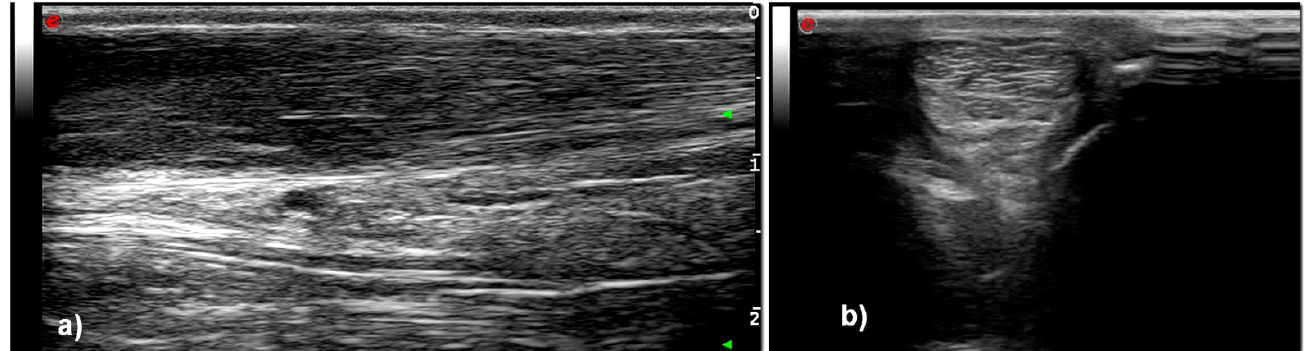
Figure 4. Ultrasonographic appearance of CCT after induction of the lesion, in longitudinal ( a ) and transverse ( b ) scan. The tendon is thicker, bowed and hypoechoic, with abnormal fibrillary architecture.